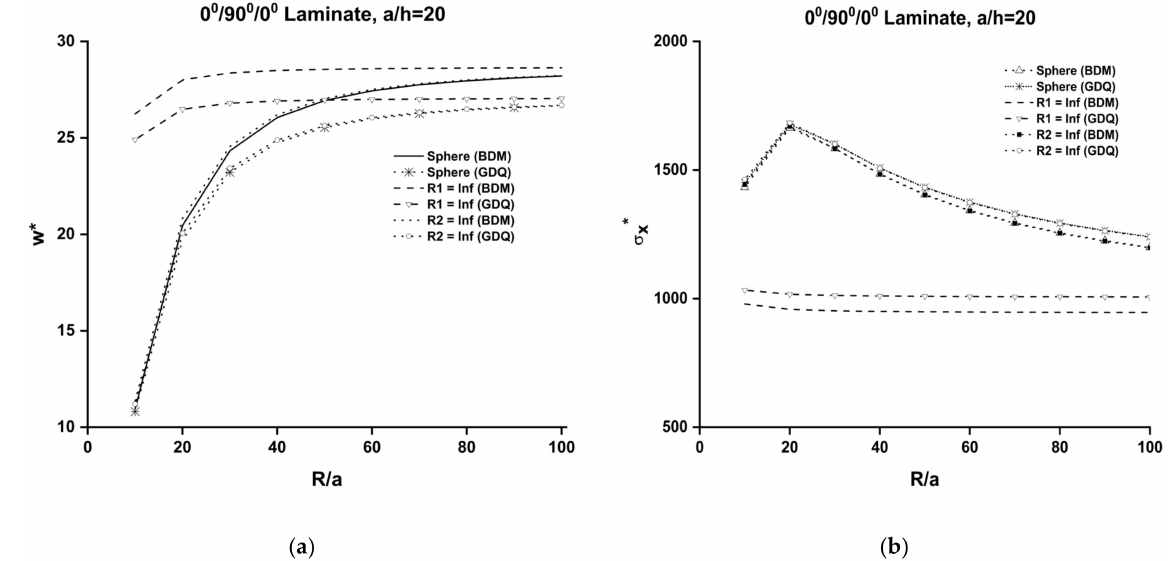
Figure 6. ( a )Variation of non-dimensional displacement, w ∗ , and ( b ) non-dimensional stresses, σ x ∗ , of moderately thick ( a / h = 20) curved panels (one spherical and two cylindrical) with an R/ a ratio for symmetric [0 ◦ /90 ◦ /0 ◦ ] lamination.